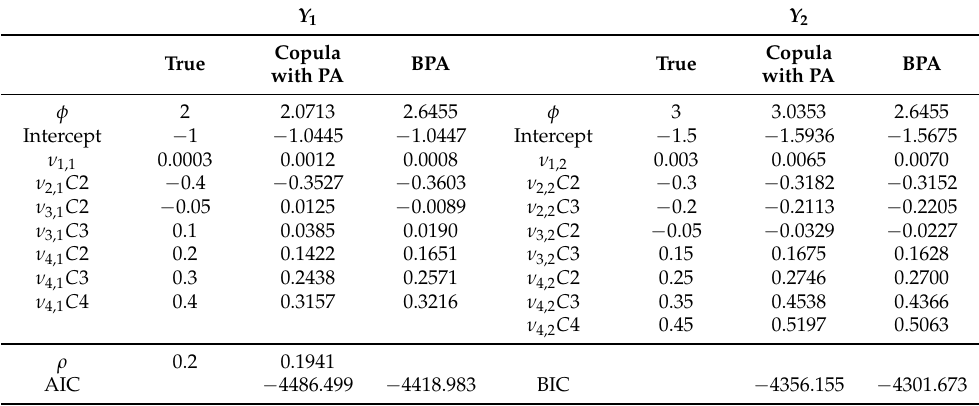
Table 4. Model comparison between Gaussian copula with two PA marginals and BPA regression model. Data are generated from Gaussian copula with two PA marginals. The AIC and BIC values are for the bivariate model.